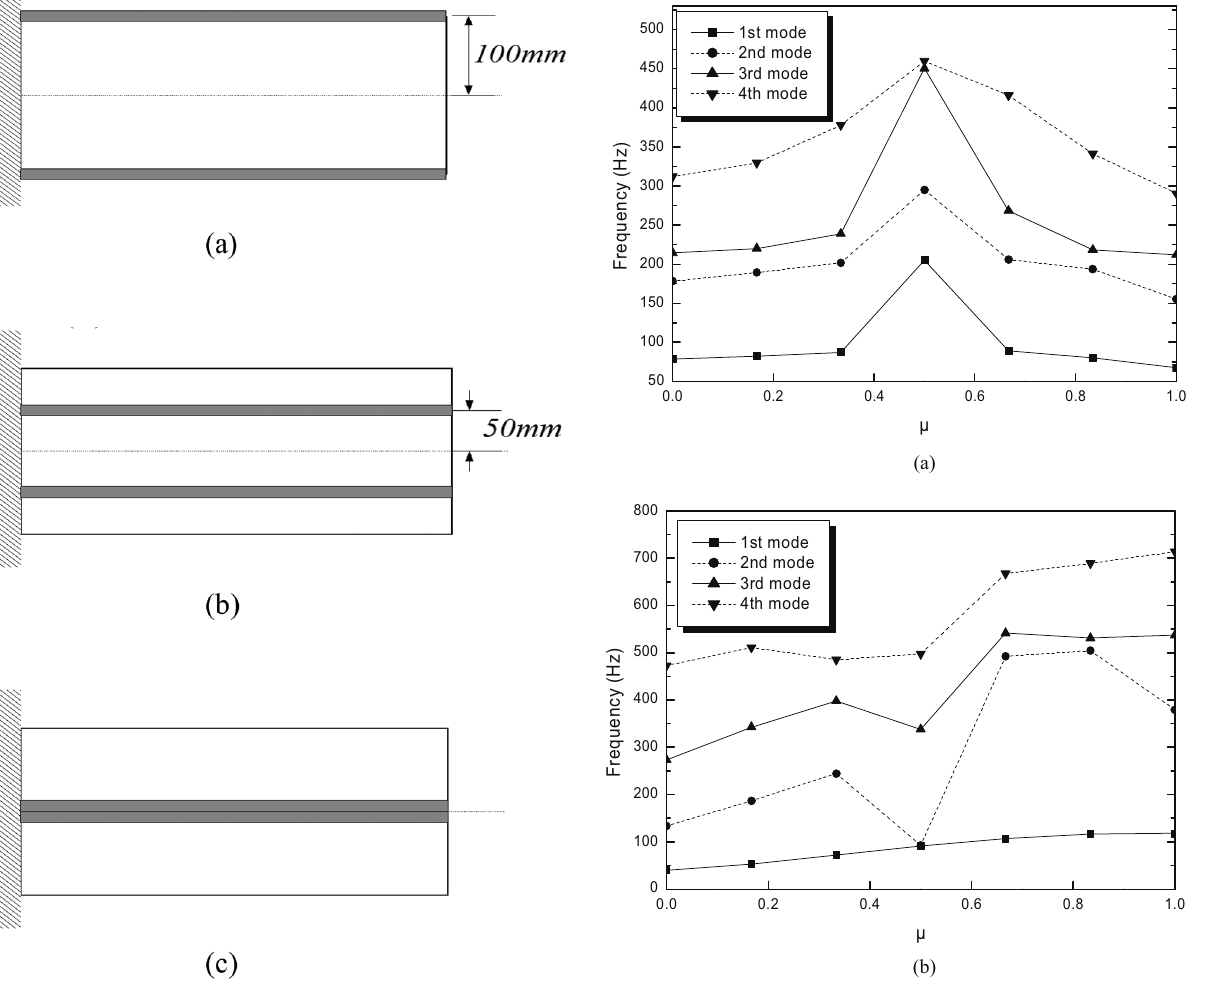
Figure 7: Natural frequencies for di ff erent shear - web locations: ( a ) bending modes and ( b ) twisting